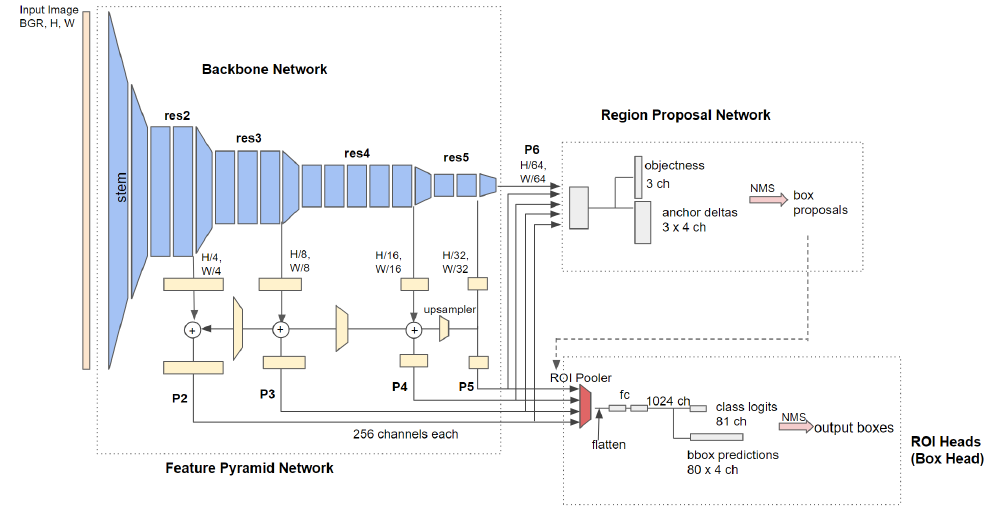
Figure 6. Overview of Faster R-CNN architecture